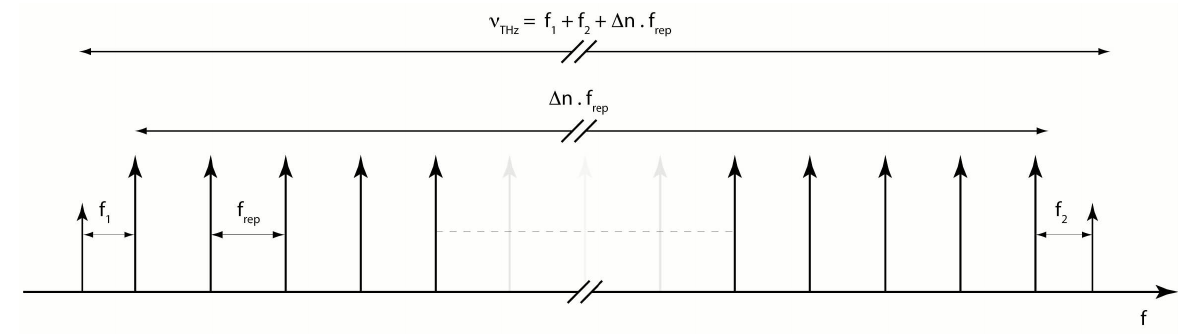
Figure 5. Optical frequency diagram containing the regularly spaced frequency comb modes and the two ECLD modes. Note that the lower frequency ECLD is locked to the low frequency side of the FC mode whereas the higher frequency ECLD is locked to the high